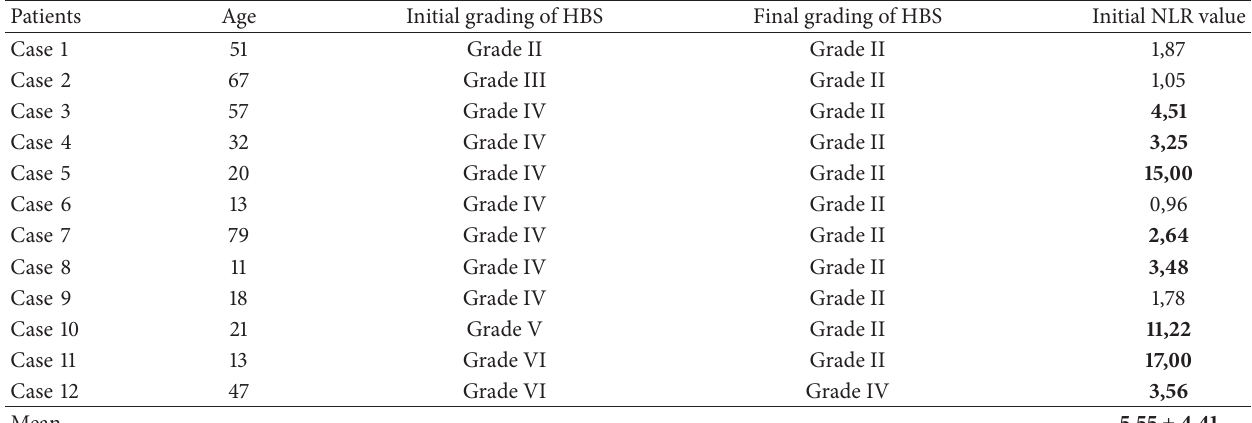
Table 4: The initial NLR values in the 12 patients with permanent facial motor function deficit.